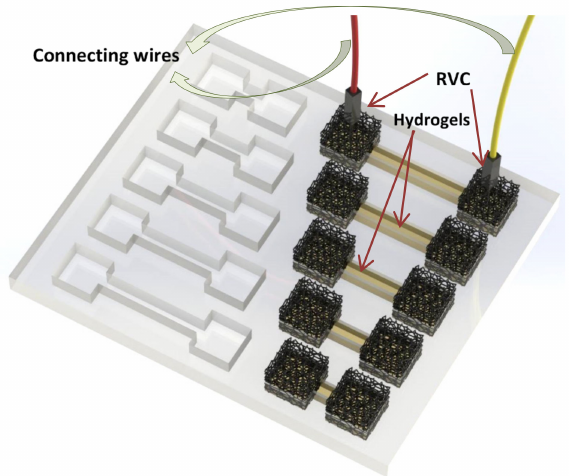
Figure 2. Hydrogel sample holder containing 5 channels varying in length between reticulated vitreous carbon (RVC) electrodes from 0.5 to 2.5 cm (height, 6 mm; channel width, 5